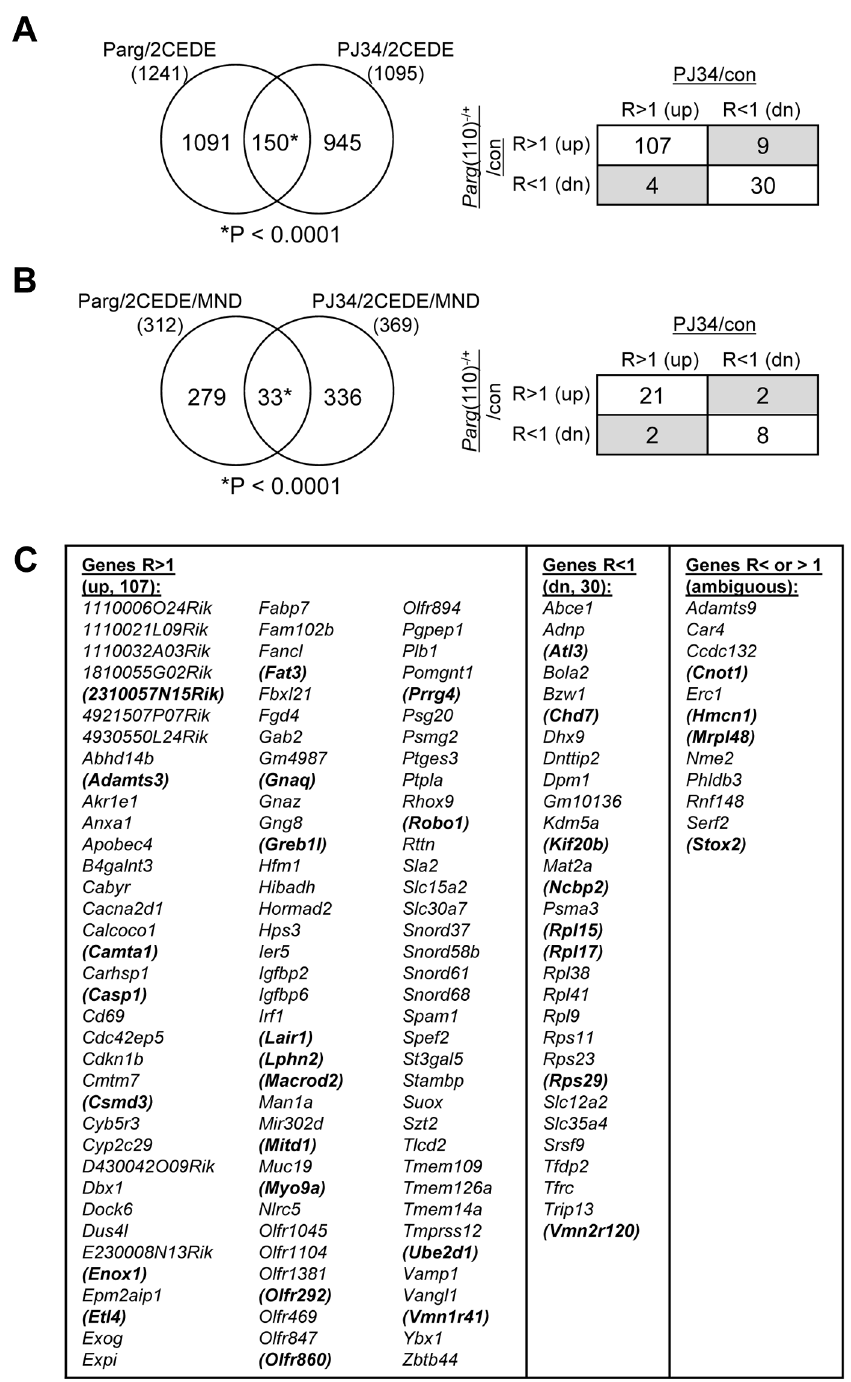
Figure 6. Shared differential gene expression in offspring from males of the two mouse models with perturbed PAR metabolism ( Parg (110) 2 / 2 , PJ34 treated). (A) The overlap of 150 differentially expressed 2-cell embryo genes (2CEDE) from Parg (110) 2 / 2 and PJ34 treated males is highly significant (Yates’ and Pearson’s Chi-squared tests using a genetic background of 19,472 genes, P , 0.0001 in both analyses, the null hypothesis would be 70 genes in the overlap). Of the 150 genes commonly differentially expressed in embryos of the two mouse models of reduced PAR metabolism, 107 are commonly expressed at higher levels and 30 are commonly down-regulated (right panel). The shaded fields indicate genes with variable expression; these also have high coefficients of variation (Cv . 5%) in the variance analyses. (B) There is also a significant overlap of 33 genes that were both differentially expressed in individual embryos and differentially histone associated in the corresponding sperm sample (2CEDE/ MND genes) between the two models ( Parg (110) 2 / 2 and PJ34-treated fathers (P , 0.0001, the null hypothesis would have been 4.8 genes in the overlap)). The relationships of differential expression of these genes (ratio . 1: R . 1 or ratio , 1: R , 1) are again very similar for the genes in the overlap (box panel to the right). (C) Identity of the genes in the overlaps shown in (A). The 33 genes in the overlap shown in (B) are bold and in brackets. Variably (ambiguously) expressed genes are listed in column 5.